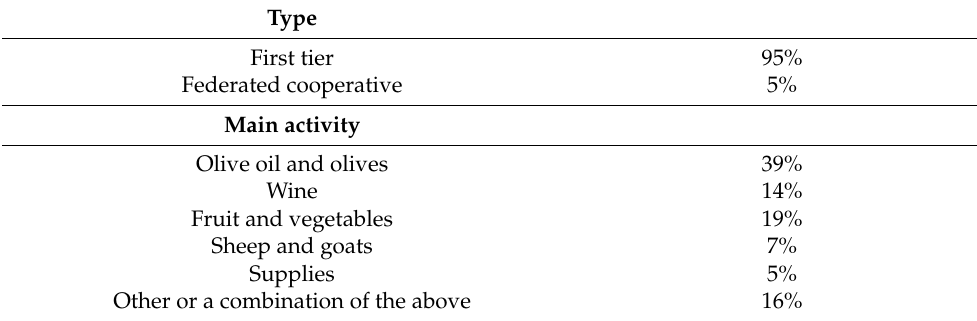
Table 3. Type of cooperatives in the sample.